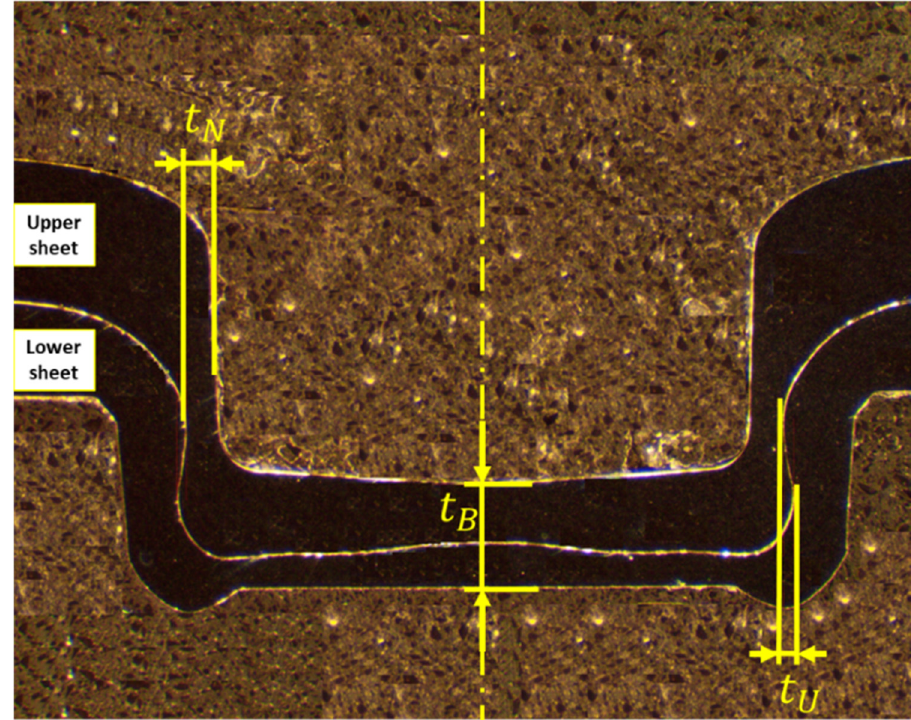
Figure 2. Cross section of clinch joint: neck thickness ( t N ) , undercut/interlock ( t U ) and bottom thickness ( t B )